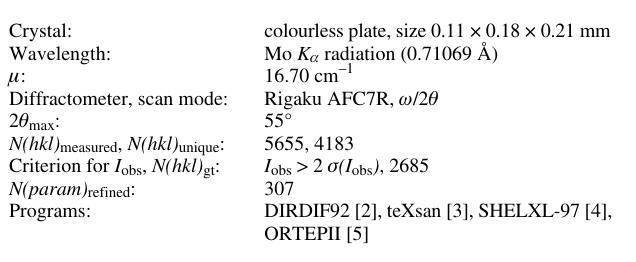
Table 1. Data collection and